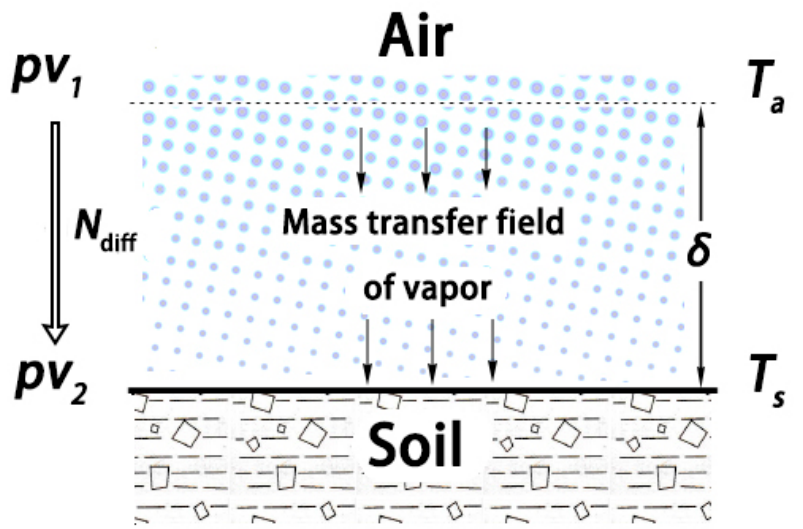
Figure 2. A sketch of moisture transportation with the difference of water vapor pressure ( pv ) in a steady air layer. N diff is the diffusion rate of water vapor and δ is the thickness of the mass transfer field.